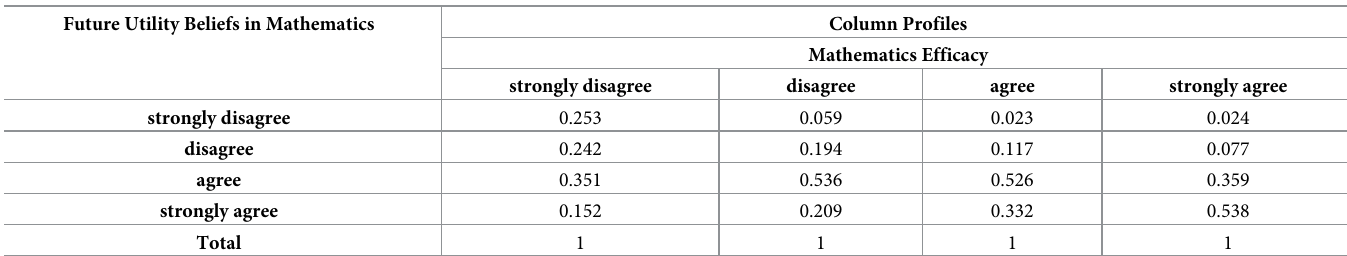
Table 3. Column profiles; for the variable Efficacy